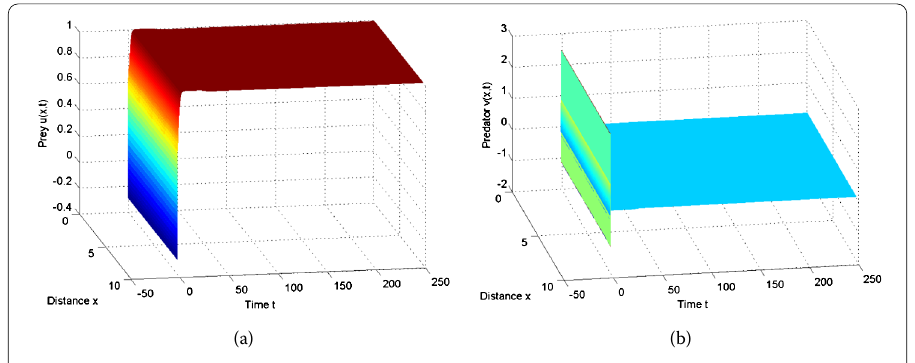
Figure 1 Numerical simulations of system (1.2) for a = 0.5, β = 1, d 1 = 1, d 2 = 100, b = 1, δ = 1.2. The positive equilibrium E ∗ (1,0) of (1.2) is globally asymptotically